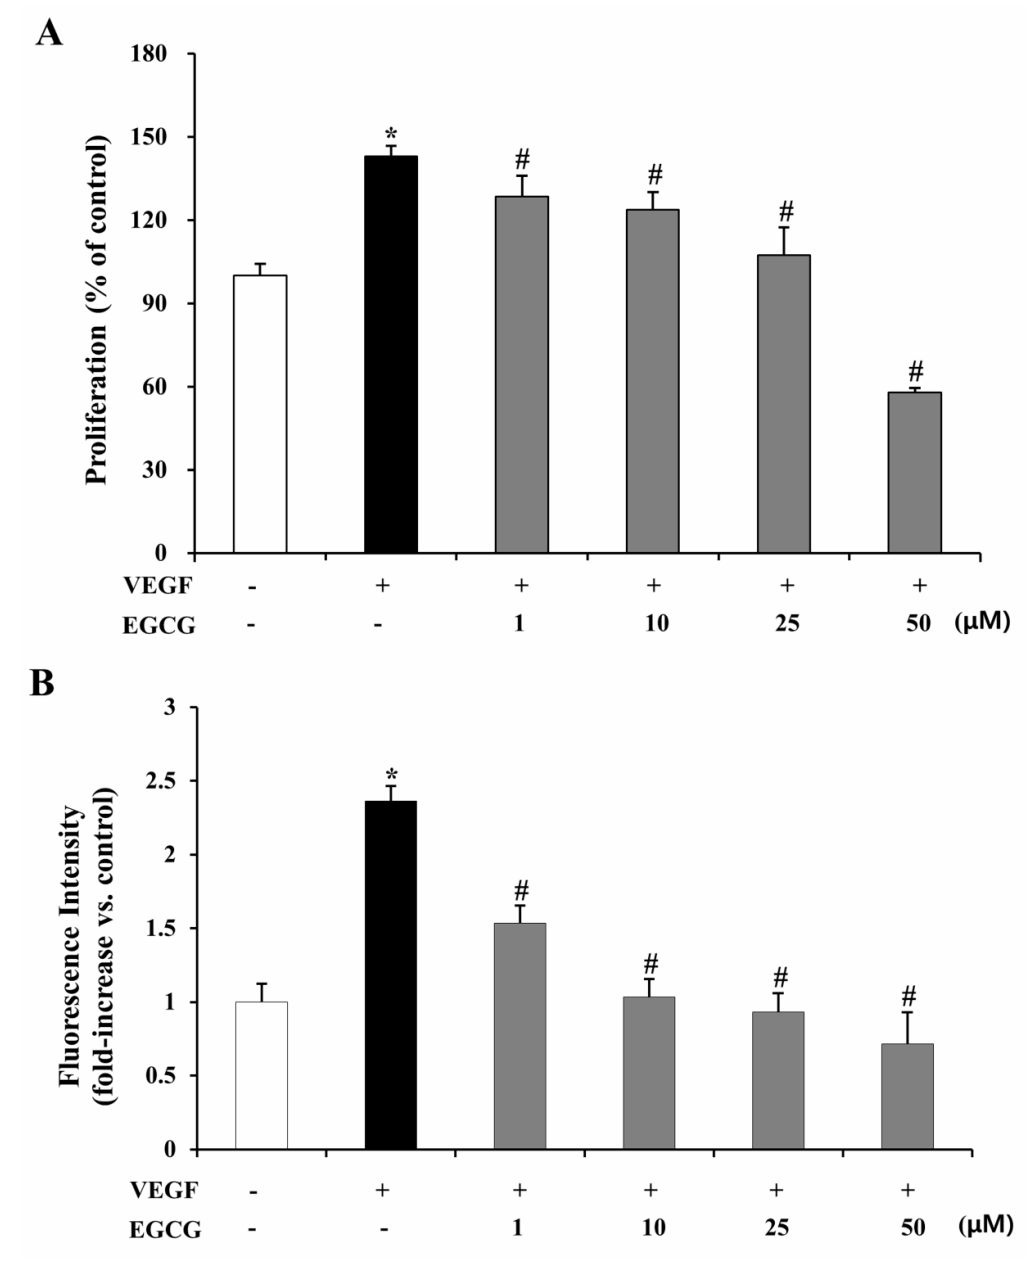
Figure 6. Inhibitory effect of EGCG on VEGF-induced proliferation and vascular permeability by HRMECs. ( A ) HRMECs were treated with 10 ng/mL VEGF or 1–50 μ M EGCG for 72 h. Cell viability was assessed by MTT assay. The results are expressed as percentage of control and are presented by mean ± SD (n = 9). *, p < 0.01 vs . VEGF and EGCG untreated; #, p < 0.01 vs . VEGF only; ( B ) HRMECs were treated with 10 ng/mL VEGF or 1–50 μ M EGCG for 72 h. Permeability was analyzed by measuring the fluorescence of FITC-labeled dextran across the monolayer cultured HRMECs. The results are expressed as fold induction of control and are presented by mean ± SD (n = 9). *, p < 0.01 vs . VEGF and EGCG untreated; #, p < 0.01 vs . VEGF